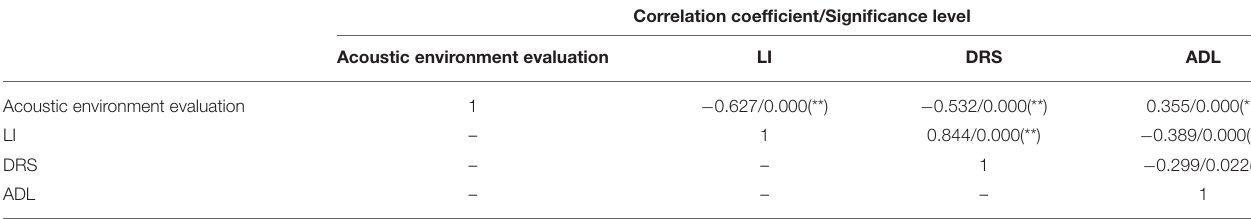
TABLE 5 | Correlation analysis of loneliness index, depression degree, and activity ability with acoustic environment comfort.